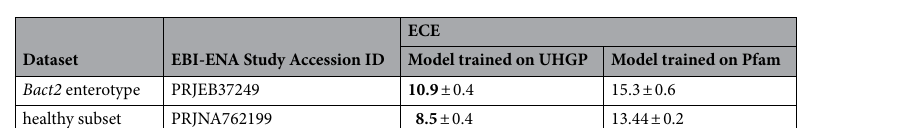
Figure 1. Workflow showing the training of the model and its subsequent use in analyses. ( A ) Training of the embedding model using UHGP dataset. ( B ) Using Bacterial SwissProt dataset and the embedding model to analyse information encoded into the embeddings.